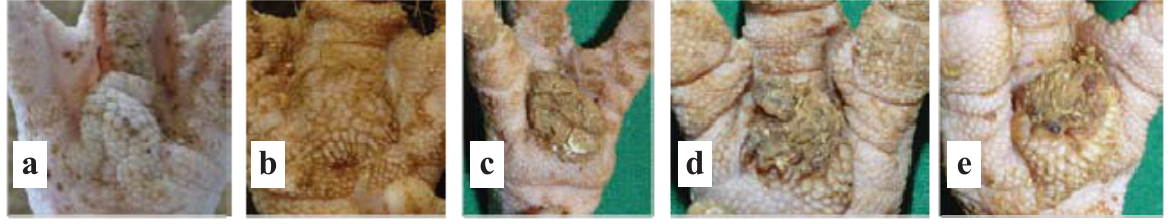
Figure 1. ( a ) Category 0: no abnormalities detected. ( b ) Category 1: hyperkeratosis, moderate hypertrophy of the plantar skin. ( c ) Category 2: high-grade hyperkeratosis with adhesive dirt. ( d ) Category 3: superficial lesions, epithelial necrosis. ( e ) Category 4: profound lesions of the plantar skin (also see Table